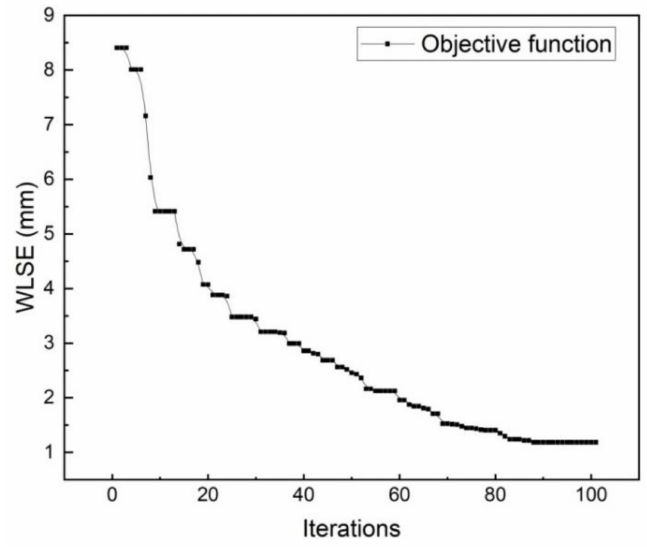
Figure 9. Convergence process of the optimization